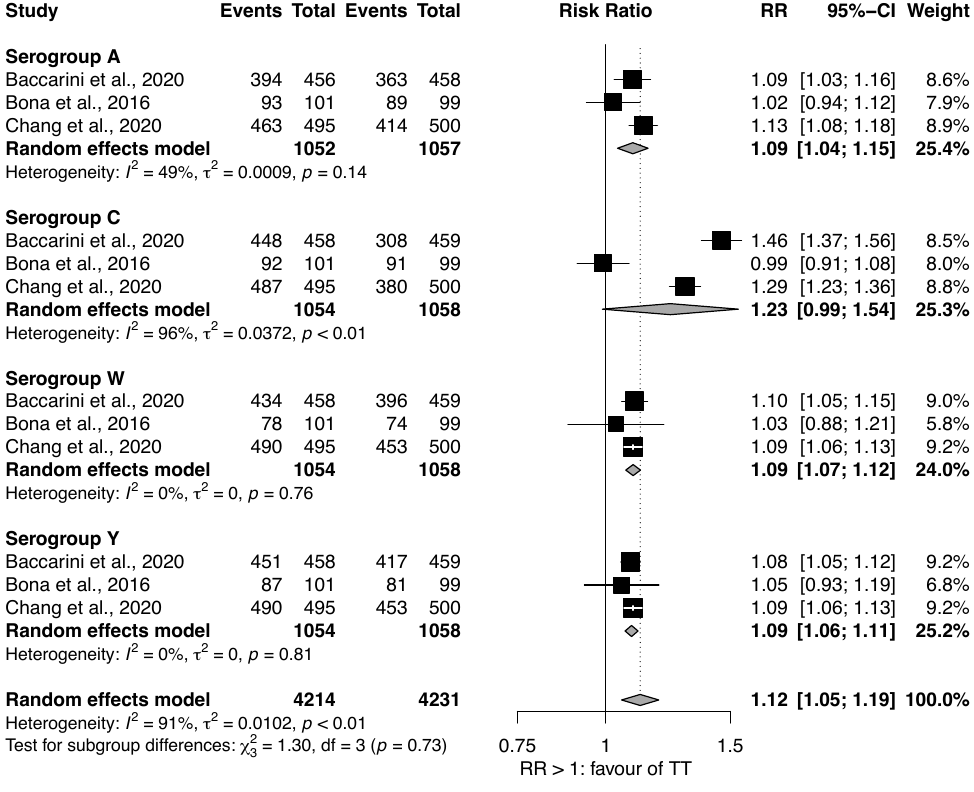
Figure 1. Efficacy of MenACWY-TT vs. MenACWY-CRM [18,20,21].